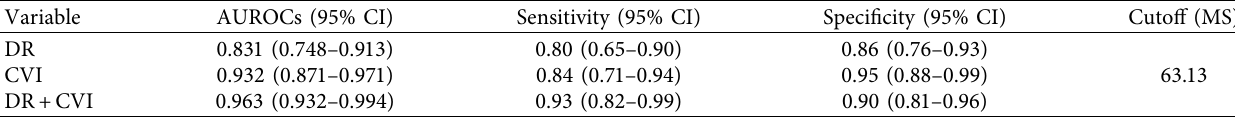
Table 3: Diagnostic value of the CVI and DR in